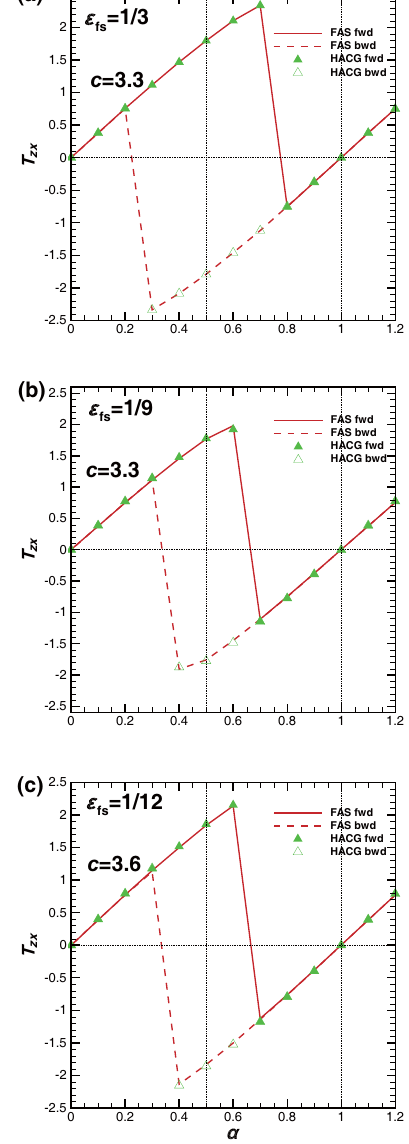
Fig. 9 Shear stress profiles at T = 0.15, T zz = –1.0, and (a) ε fs = 1/3, (b) ε fs = 1/9, and (c) ε fs = 1/12 are generated in the fully atomistic and multi-scale simulations. The fully atomistic profile (forward, with a solid line; backward, with a dashed line) and multi-scale profile (forward, with filled triangles; backward, with hollow triangles).